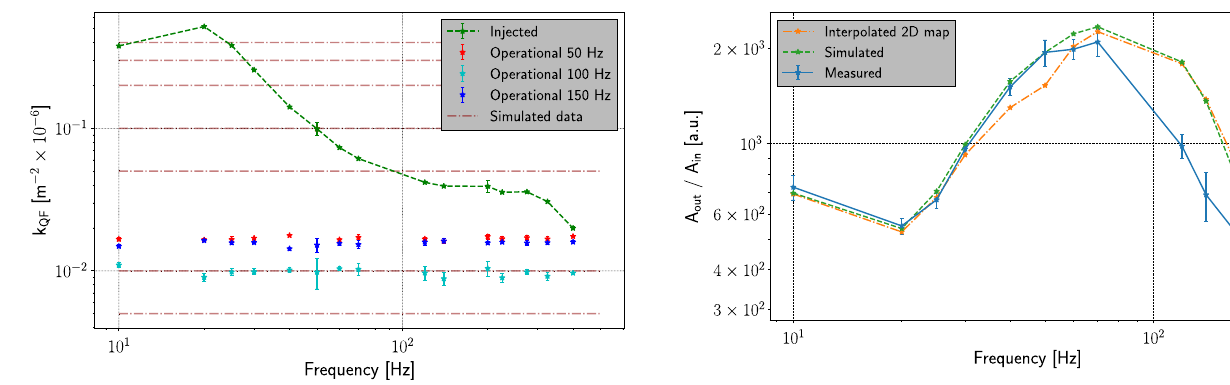
line).FIG. 11. The green points (connected by dashed lines) show the strength-equivalent ripple amplitude and frequency of the sinus- oidal ripple injected using the waveform generator. The red, light blue and blue points show the 50, 100 and 150 Hz harmonics components on the measured current coming from the power supply ripples. The horizontal lines are the ripple amplitudes simulated in Sec. II A. All the points that generated the green curve have been injected as voltage ripples of fixed 240 mV